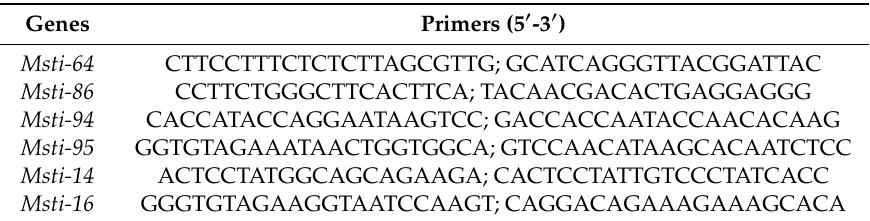
Table 2. List of primers used for the